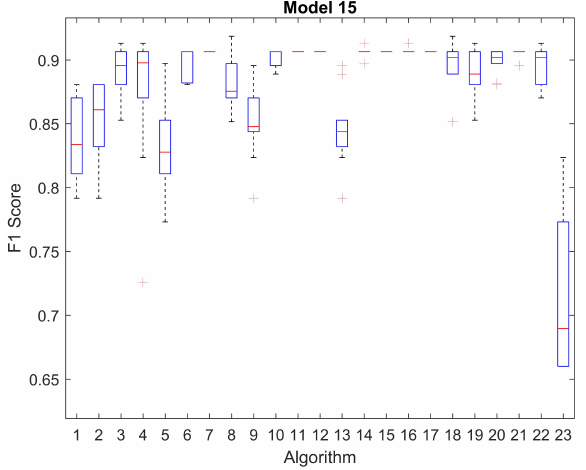
Figure A14. F1-score of Model 15 for the different algorithms. The 23 algorithms are represented in the x -axis, and the accuracy is shown in the y -axis.